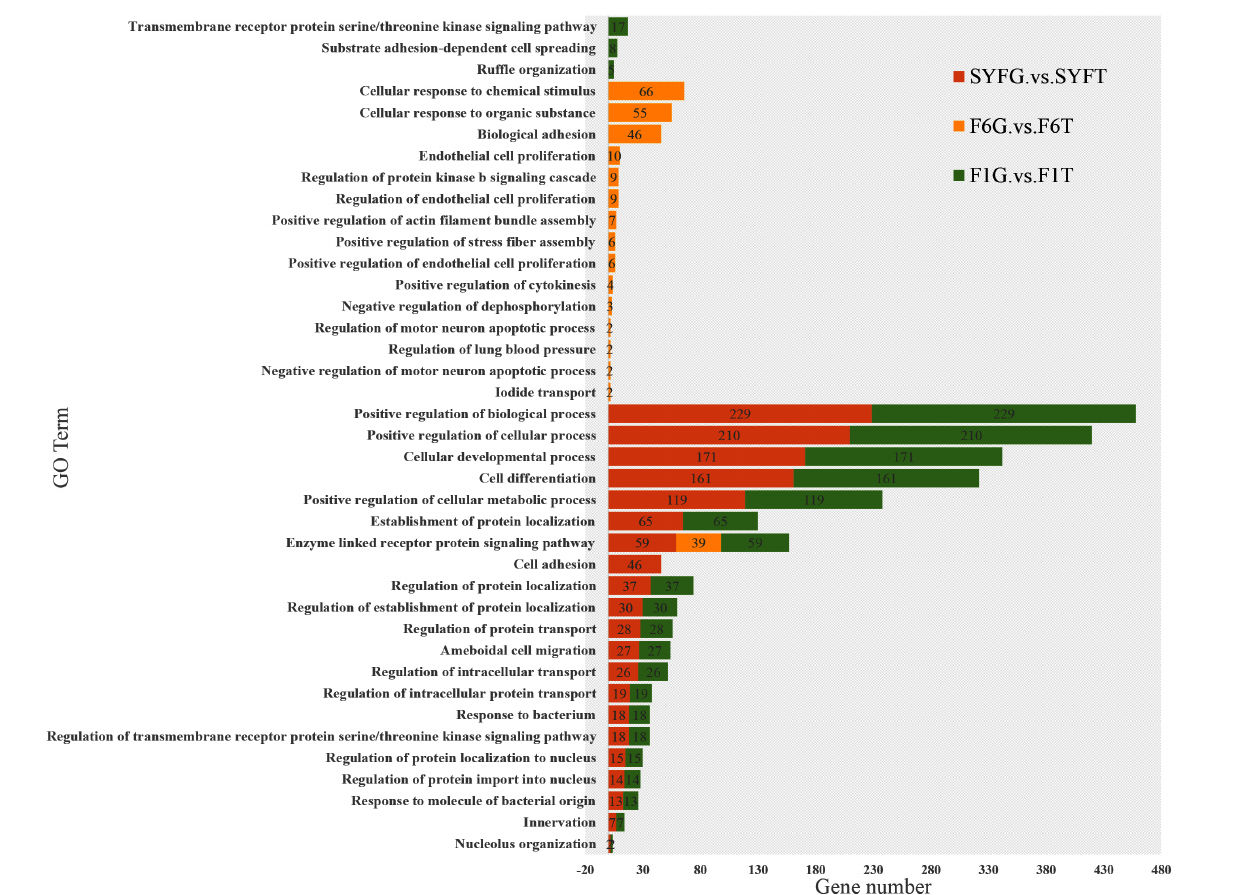
FIGURE 5 | Biological process of host genes of DE circRNAs in different comparison group. DE, differentially expressed. SYF, small yellow follicle; F6, the smallest hierarchical follicle; F1, the largest hierarchical follicle. G, granulosa cell; T, theca